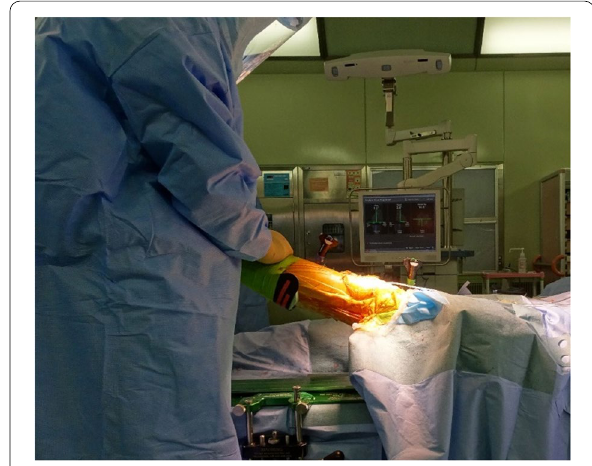
Table 2 Postoperative HKA-angle and implant sagittal alignment HKA-angle Femoral component sagittal align- ment Posterior tibial SD standard deviation, HKA angle Hip-knee-ankle angle